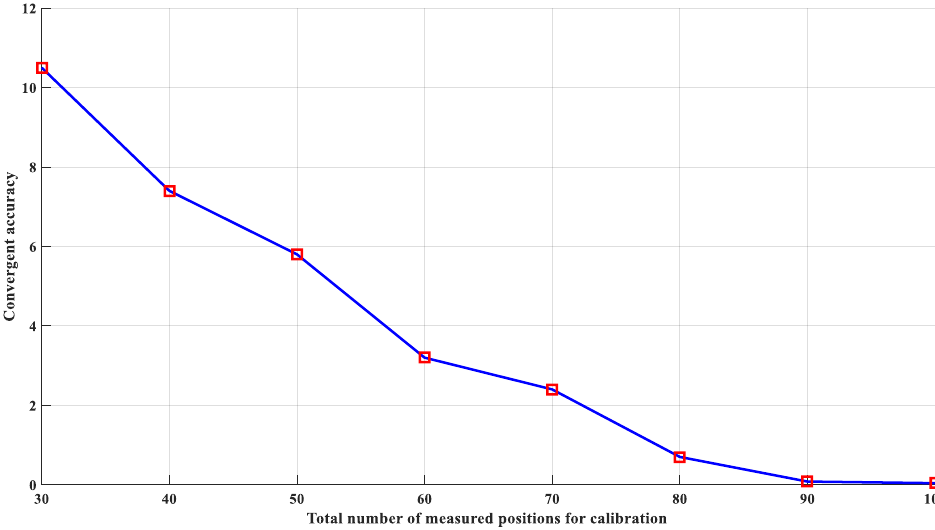
Figure 7. Convergent accuracies of different numbers of measured positions. Table 3. Nominal and calibrated values of coefficients from motor positions to cable Table 2. Nominal and calibrated values of initial cable lengths.